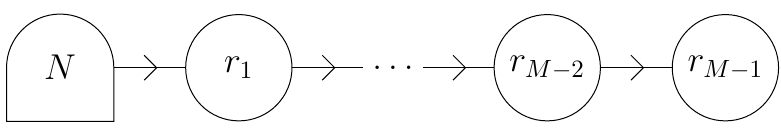
Figure 5 . The quiver which is dual to the one in Fig-